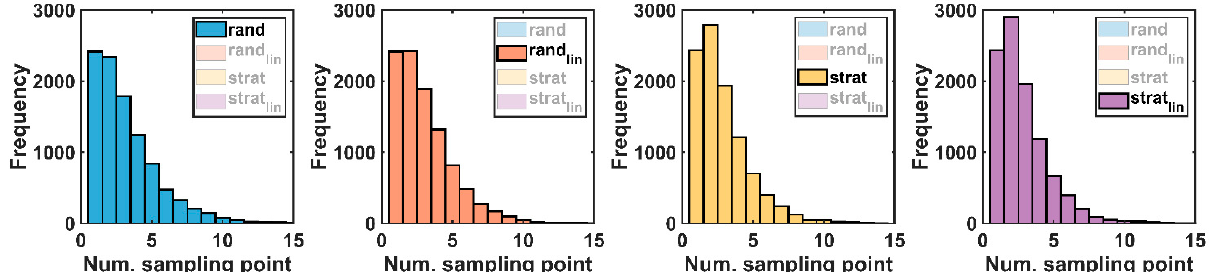
Figure 5. Distribution of the number of sampling points needed to meet the T10 threshold for all simulated cases ( n = 10,000) aggregating data from all FLEX pixels in Selhausen (Germany) and Braccagni (Italy) experimental sites using a random sampling, a random sampling with a linear combination model, a stratified random sampling and a stratified random sampling with a linear combination model.